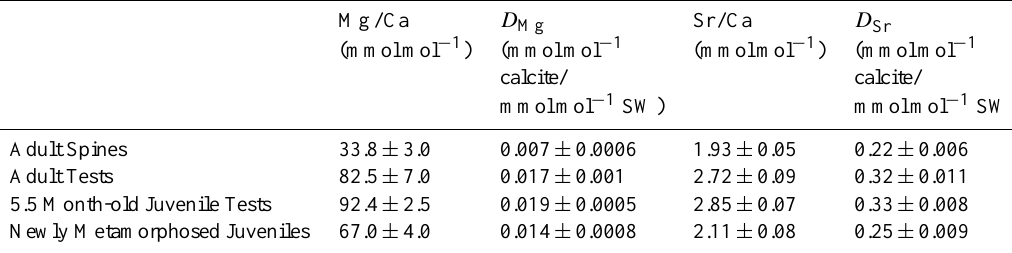
Table 4. Mean ( ± 1SD) trace elemental ratios of S. purpuratus life history